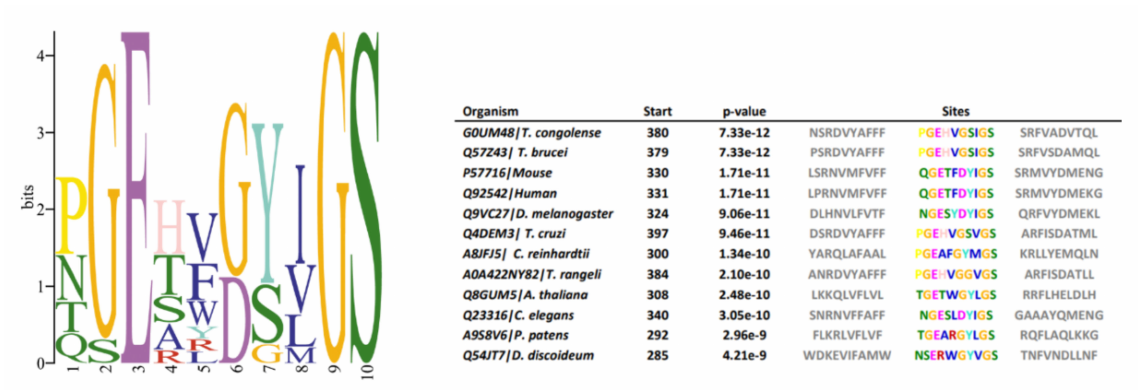
Figure 6. Sequence logo of nicastrin conserved motif. Multiple sequence alignment of different organisms ( T. congolense , T. cruzi , T. brucei , T. rangeli , C. elegans , D. discoideum , P. patens , Chlamydomonas reinhardtii , M. musculus , A. thaliana , C. reinhardtii , D. melanogaster and H. sapiens ) show amino acid variations in nicastrin motif DYIGS.